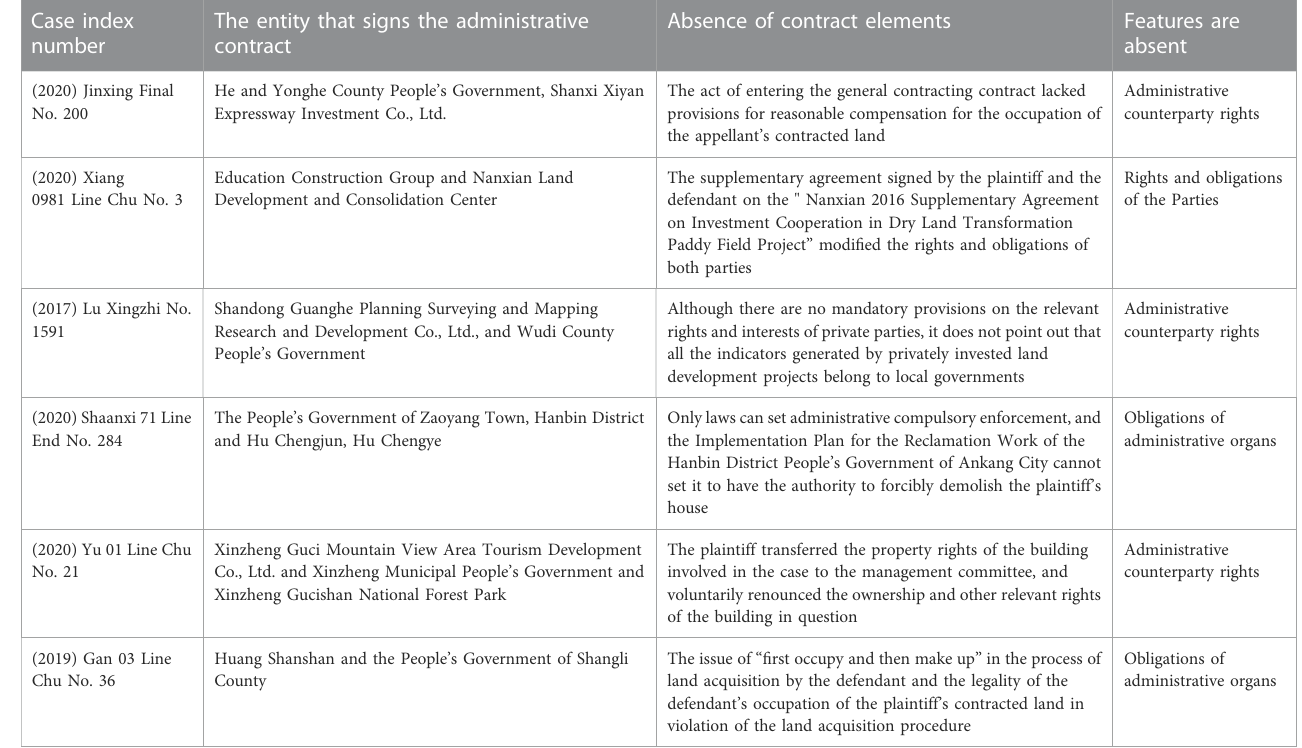
TABLE 3 Lack of structural elements of “ rights-obligations ” in administrative contracts for cultivated land